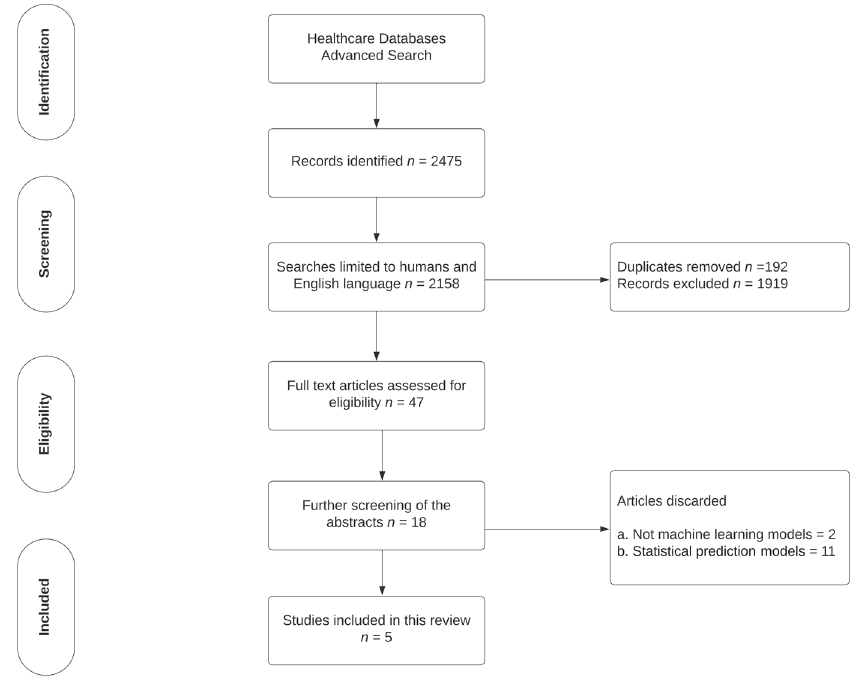
Figure 2. A search-strategy flow diagram adapted from Moher et al., 2009 [9], as per the Preferred Reporting Items for Systematic Reviews (PRISMA) 2009 guidance.